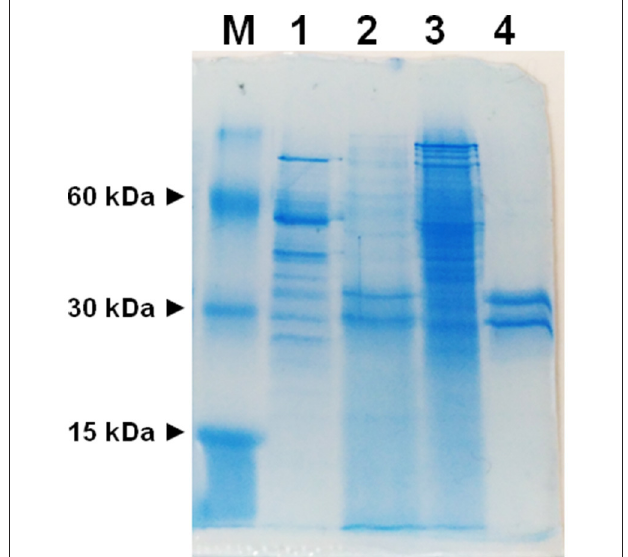
FIGURE 1 | SDS-PAGE of mitochondrial extracts and HTP chromatography eluates. M, marker proteins (bovine serum albumin, carbonic anhydrase and cytochrome c); (1) potato mitochondrial extract (12.6 µ g), (2) potato mitochondrial hydroxyapatite eluate (65 µ g), (3) liver mitochondrial extract (42 µ g), (4) liver mitochondrial hydroxyapatite eluate (25 µ